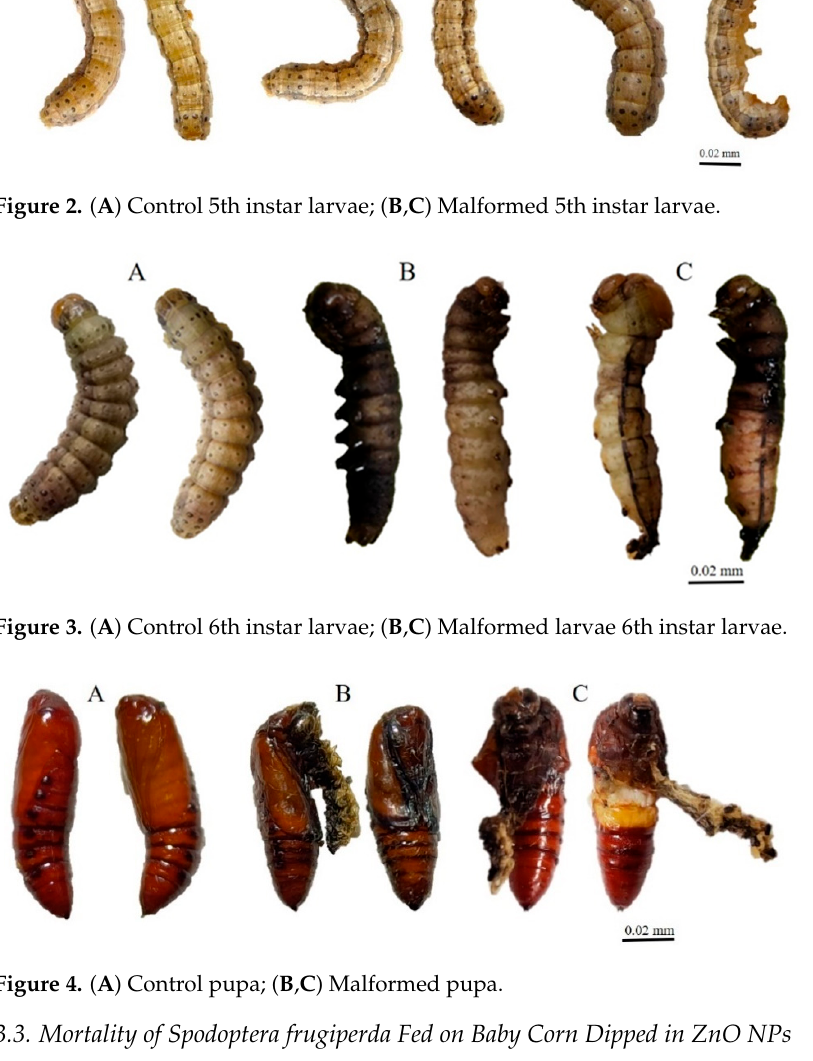
Figure 4. ( A ) Control pupa; ( B , C ) Malformed pupa.